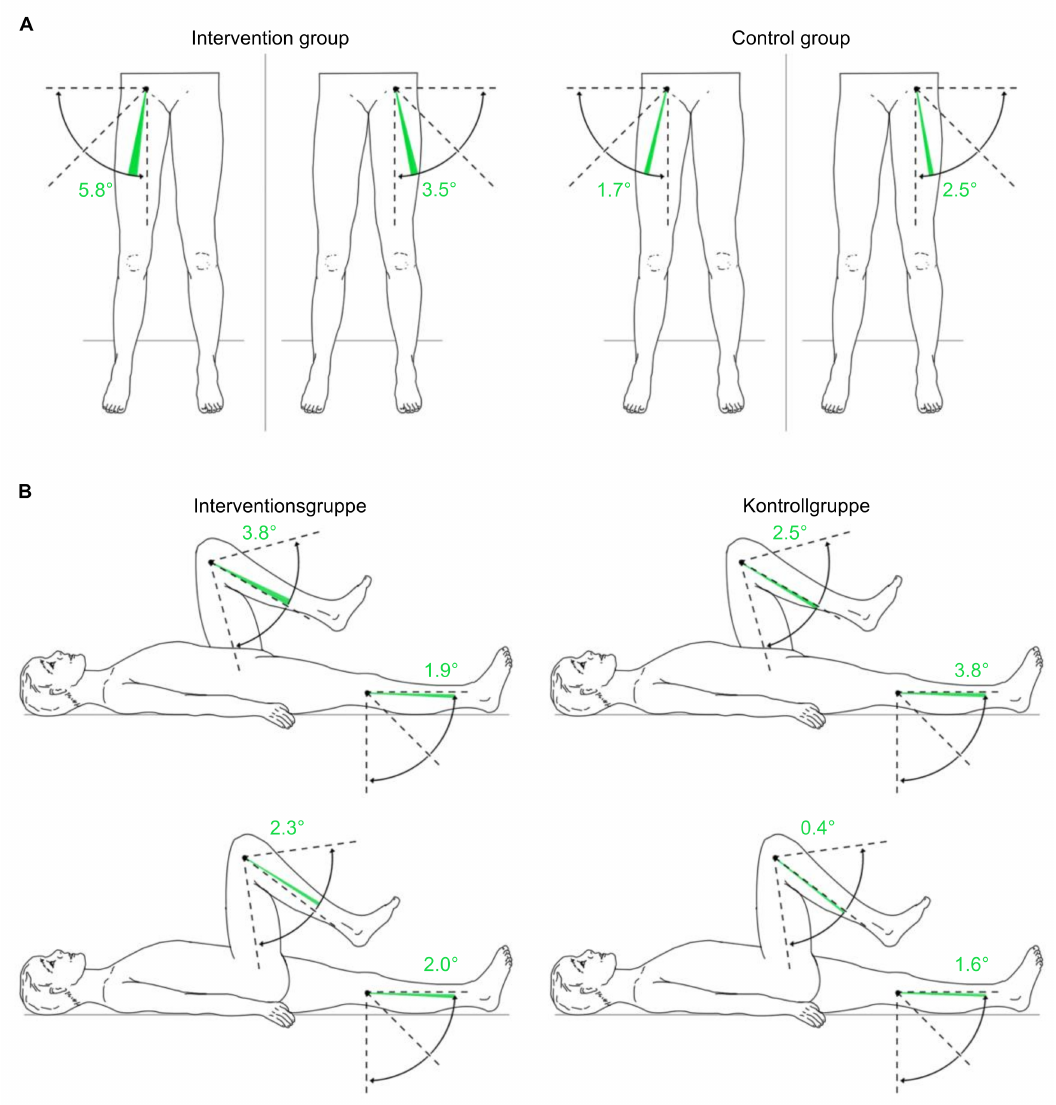
Figure 8. Changes in passive range of motion of the hip and knee joints in the intervention group and control group from T1 to T2 on average. ( A ): hip joint on frontal plane; ( B ): knee joint on sagittal plane. Green area: positive delta results from T1 to T2; red area: negative delta results from T1 to T2; T1: measurement pre-intervention; T2: measurement post-intervention; n = 25. Source: author’s